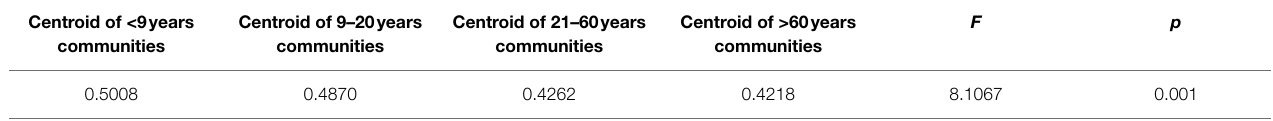
Centroid of <9 years